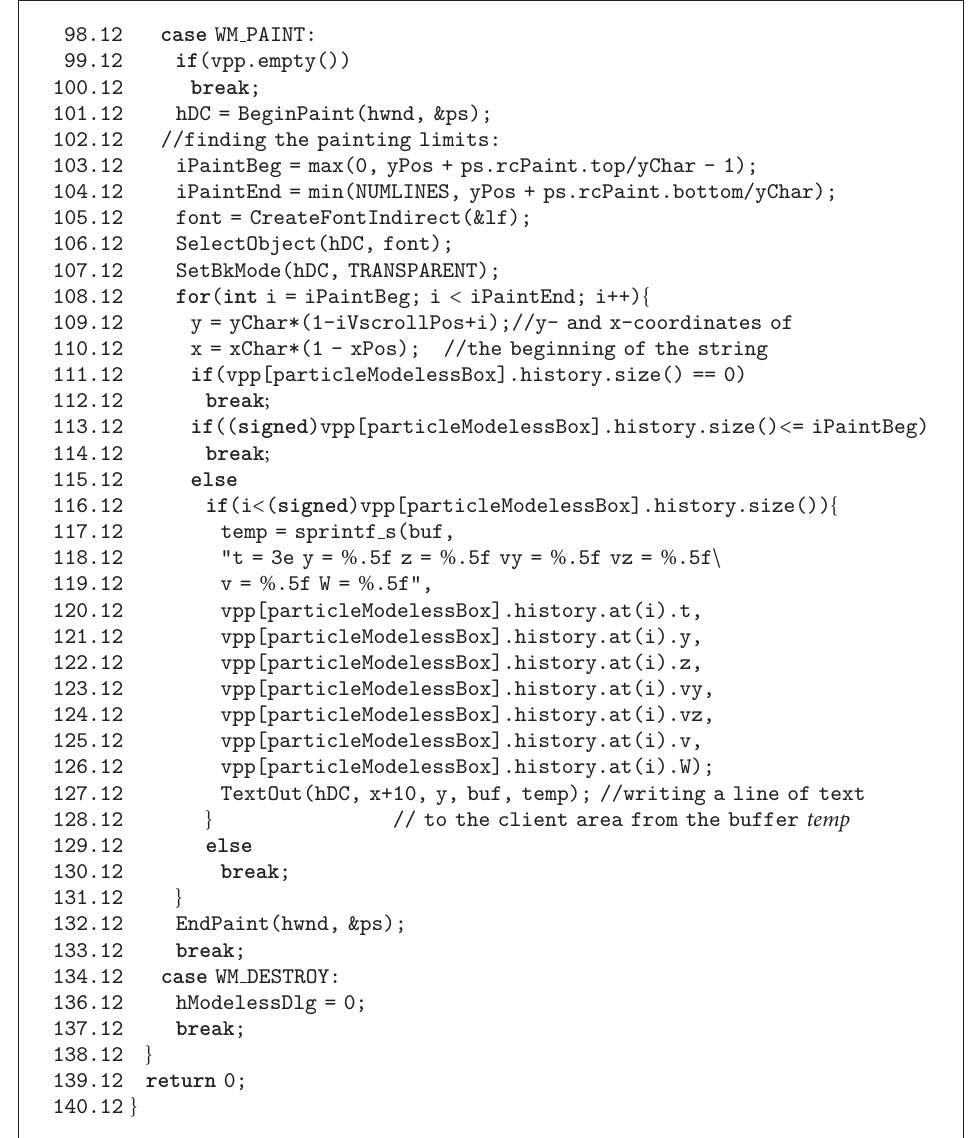
Algorithm 12: Modeless dialog box: function ModelessDialogProc (part